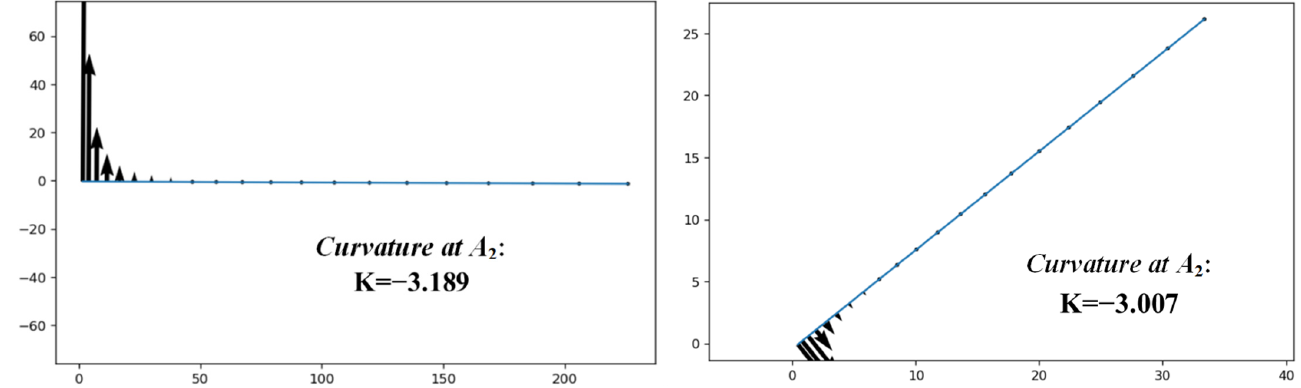
Figure 13. Apple shoulder curvature.